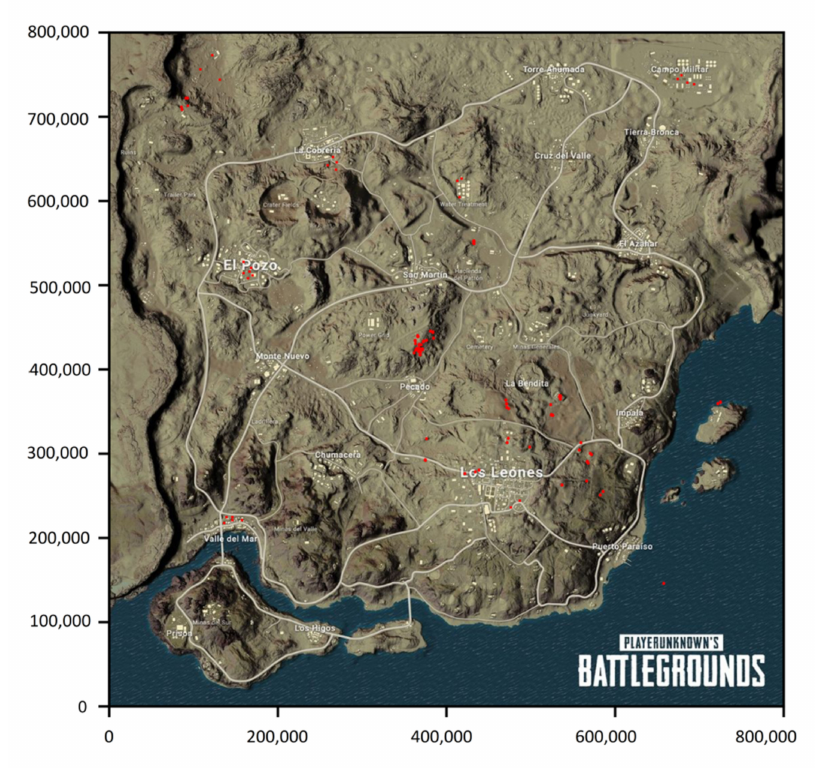
Figure 11. Duels occurring across the map throughout the game.